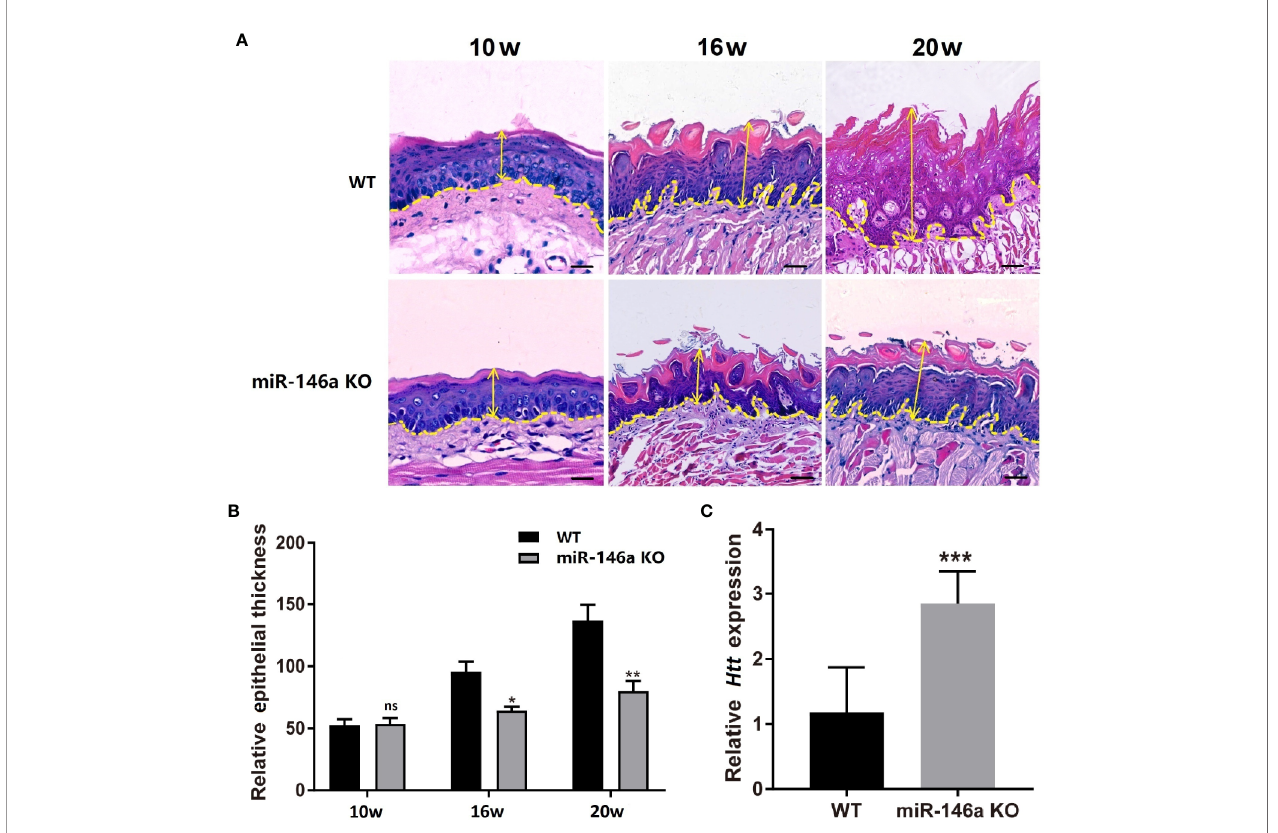
FIGURE 7 | Knocking out of miR-146a in mice mitigates OSCC progression and tongue epithelial layer damage. (A) Representative images of histological section (H&E staining) of tongue tissue of wild-type and miR-146a knockout mice with OSCC. (B) Quantitative analysis of tongue epithelium thickness. (C) HTT mRNA expression pattern in wild-type and miR-146 knockout mice. Data are presented as mean ± SD form three independent experiments in triplicate. Signi fi cant effect of treatment compared to WT, *P < 0.05, **P < 0.01, and ***P < 0.001. KO, knockout; WT, wild-type; ns, not signi fi cant. Scale bar, 100 m m.